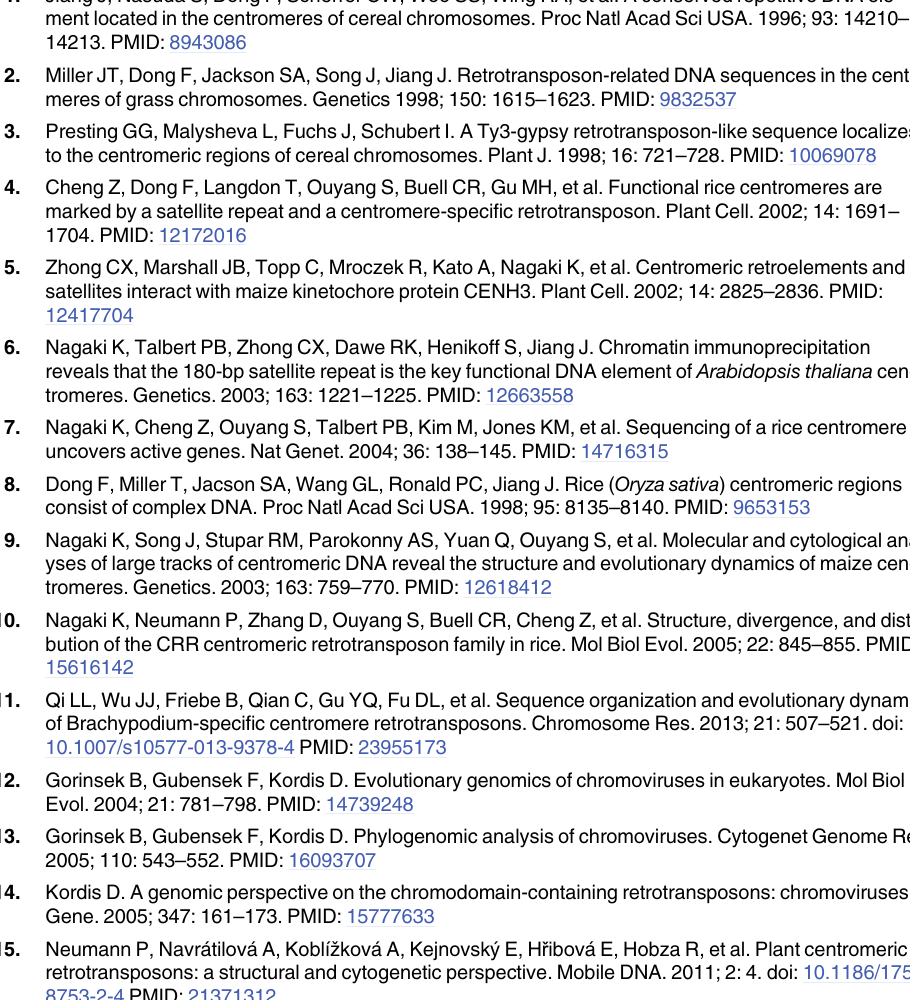
(JPG) S1 Table. List of primer sequences used for qPCR